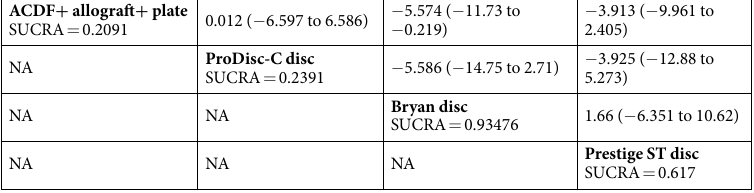
Table 2. Indirect comparison results and SUCRA of NDI